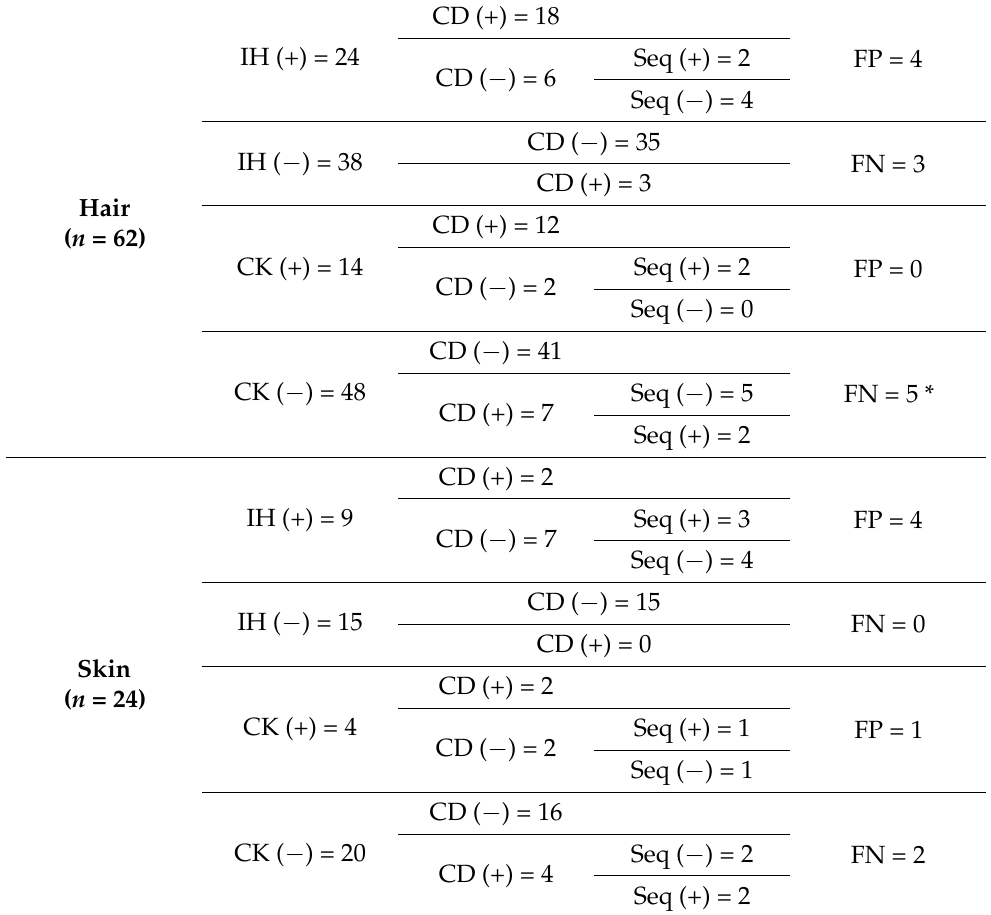
Table 7. False positive and negative cases of the in-house (IH) and the EurobioPlex (CK) PCR assays according to direct ITS sequencing results (reading from left to